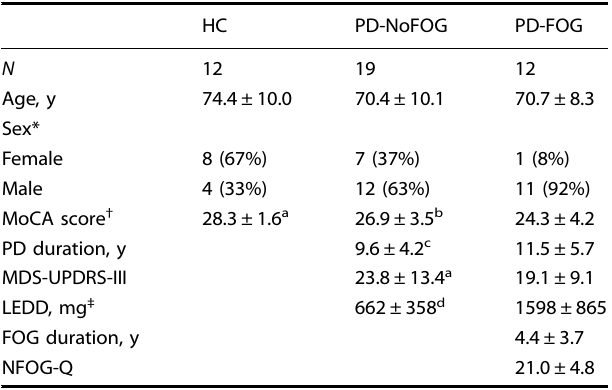
Table 1. Demographic and clinical features of the study sample.